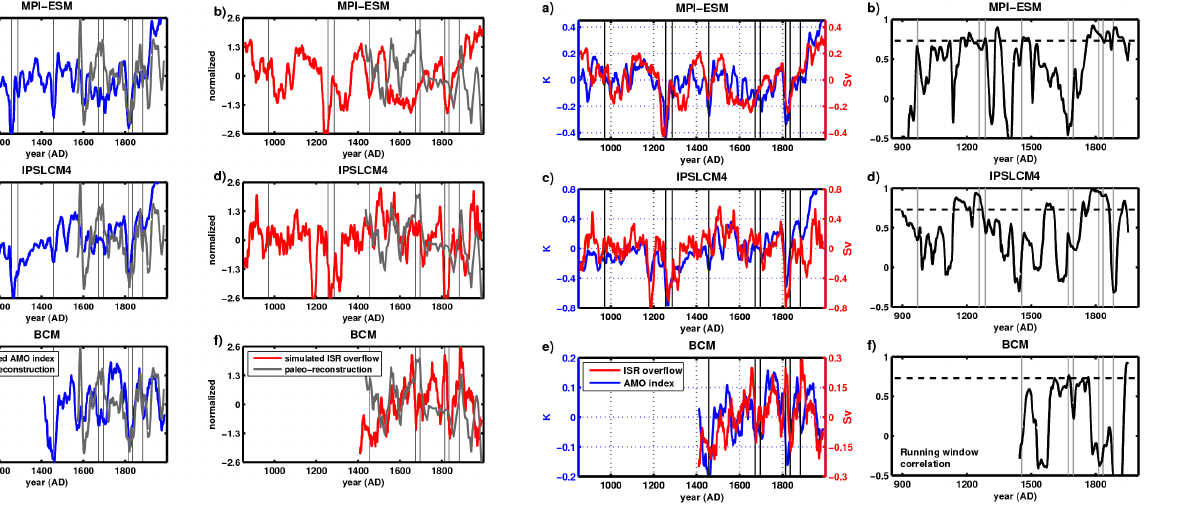
Figure 3. Left panels: simulated anomalous AMO index (blue line; in K) and overflow transport across the ISR (red line; in Sv) in MPI- ESM (a) , IPSLCM4 (c) and BCM (e) . All time series are annual val- ues with a 21-year running mean filter applied. Right panels: run- ning correlation (junk length of 75 years) between the AMO index and the overflow transport across the ISR from the left panels in MPI-ESM (b) , IPSLCM4 (d) and BCM (f) . In all panels, the ver- tical lines indicate years with major volcanic eruptions (following Zanchettin et al., 2012). Correlation coefficients above the dashed line in (b) , (d) and (f) are statistically significant at the 95% confi- dence level (significance level: